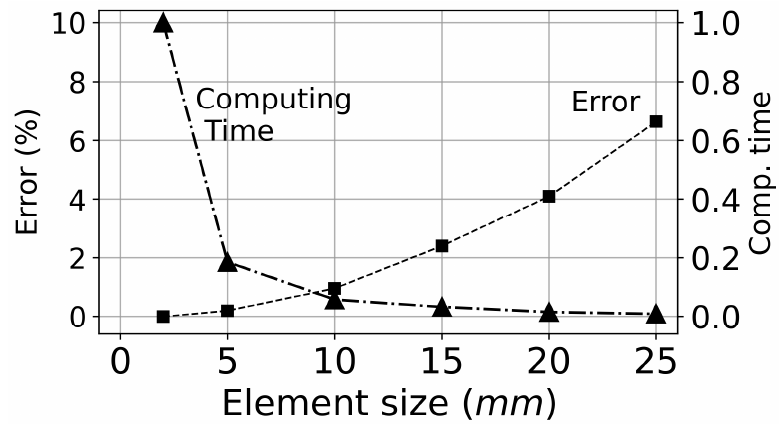
Figure 5. Analysis error and computational time vs. element size.